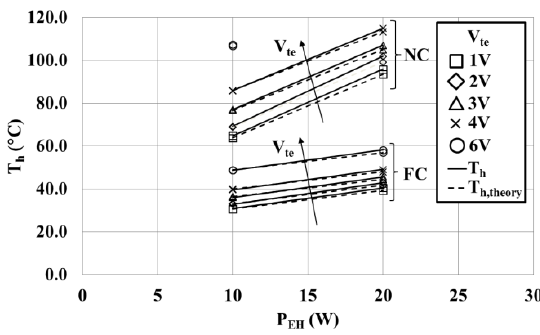
Figure 12. Comparison of experimental and predicted T h for the FHS ‐ TE assembly.